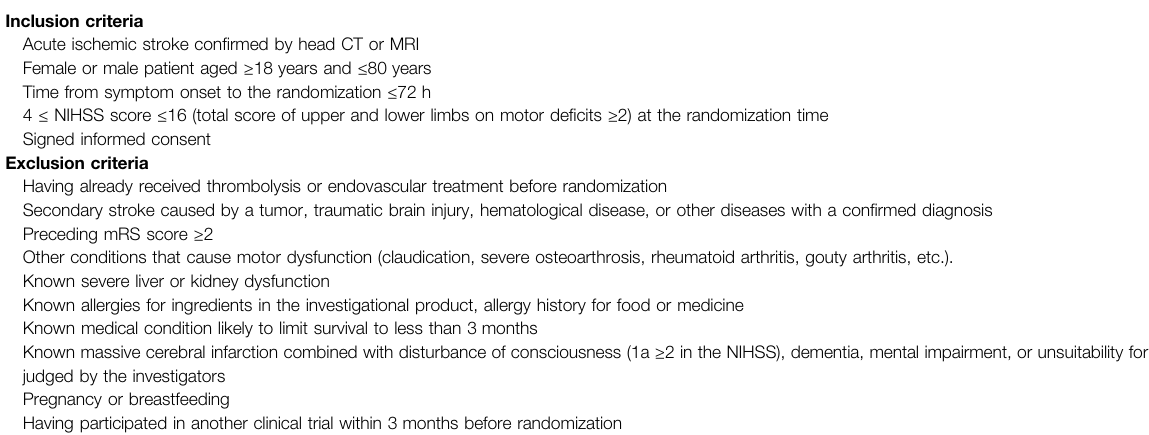
TABLE 1 | Inclusion and exclusion criteria of the EXPECT trial. Inclusion criteria Acute ischemic stroke con fi rmed by head CT or MRI Female or male patient aged ≥ 18 years and ≤ 80 years Time from symptom onset to the randomization ≤ 72 h 4 ≤ NIHSS score ≤ 16 (total score of upper and lower limbs on motor de fi cits ≥ 2) at the randomization time Signed informed consent Exclusion criteria Having already received thrombolysis or endovascular treatment before randomization Secondary stroke caused by a tumor, traumatic brain injury, hematological disease, or other diseases with a con fi rmed diagnosis Preceding mRS score ≥